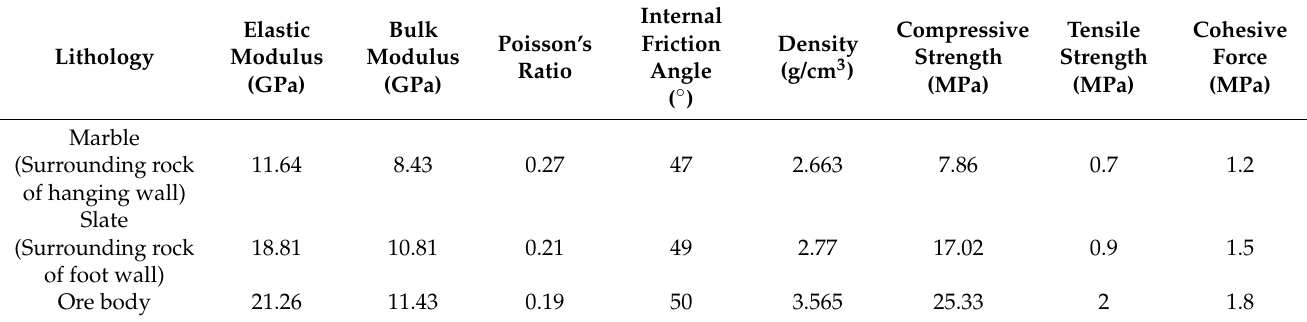
Table 3. List of material parameters selected for the numerical